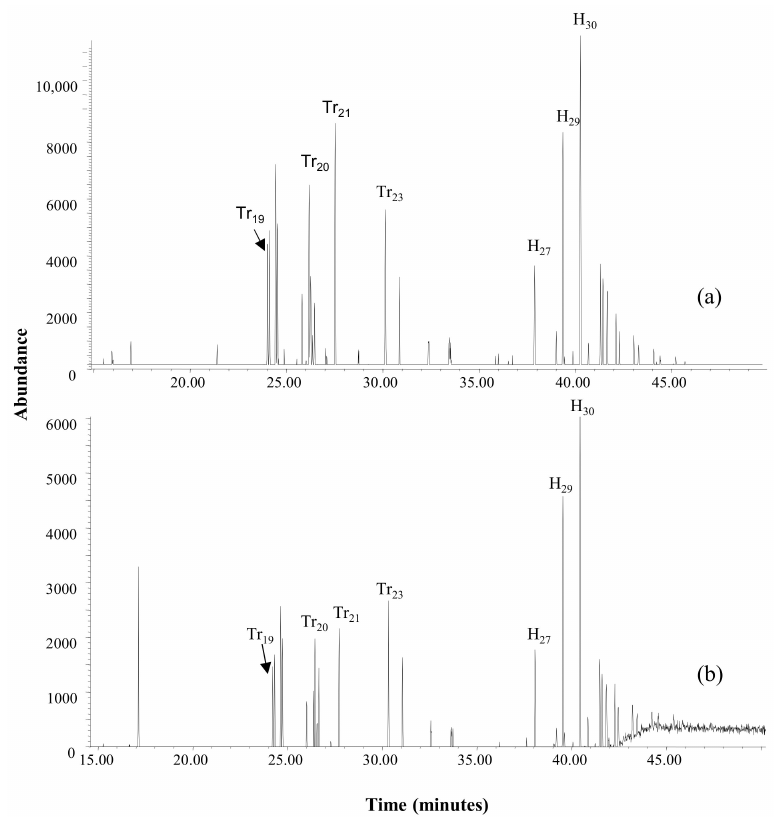
Figure 6. Chromatographic fingerprints of m / z 191 of ( a ) remaining oil after 120 h in the abiotic test and ( b ) remaining oil after 120 h of Y. lipolytica ’s growth in seawater with 1% v / v of